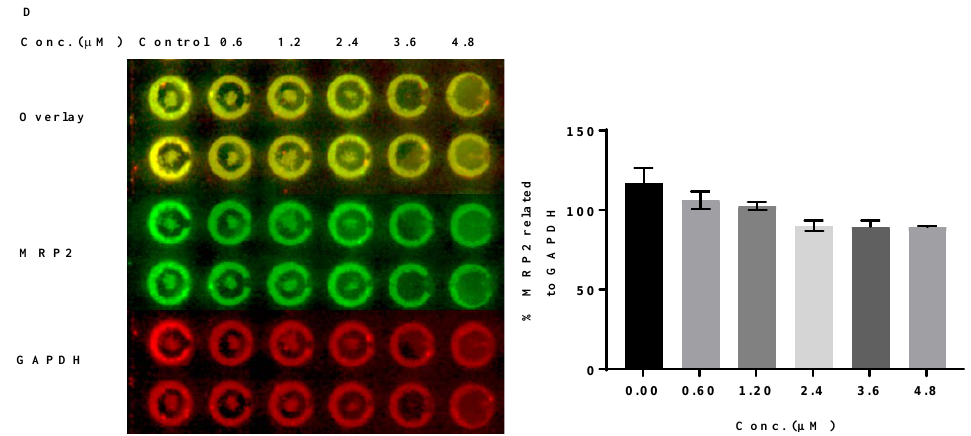
Figure 4. In-Cell Western analysis of predicted protein targets of NO- ∆ -16-CIEA 14a : ( A ) Analysis of EGFR phosphorylation in HepG2 cells; ICW plate image and p-EGFR intensity in 800 channel was normalized to total EGFR intensity in 700 channel. ( B ) Analysis of ERK1/2 phosphorylation in HepG2 cells; ICW plate image and p-ERK1/2 intensity in 800 channel was normalized to total ERK1/2 intensity in 700 channel. ( C ) Analysis of MEK1/2 phosphorylation in HepG2 cells; ICW plate image and p- MEK1/2 intensity in 700 channel was normalized to β -actin intensity in 800 channel. ( D ) Analysis of MRP2 inhibition in HepG2-R cells; ICW plate image and MRP2 intensity in 800 channel was normalized to GAPDH intensity in 700 channel. Values reported are averages ± SD of at least two measurements.